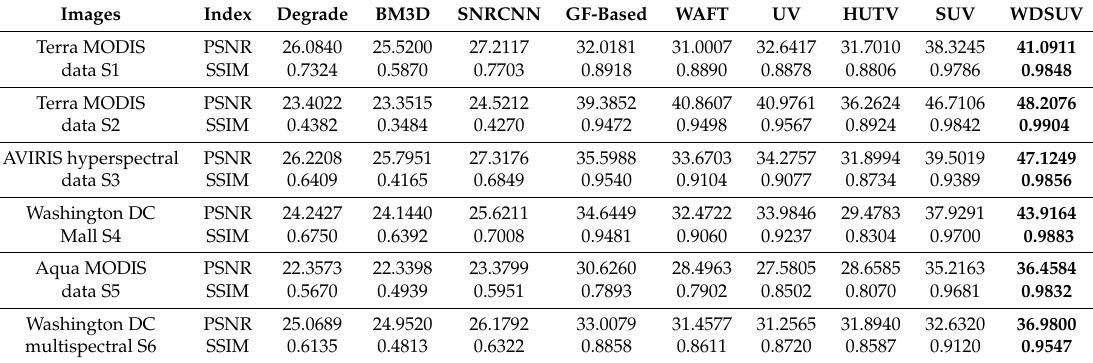
Table 1. Quantitative assessment of six simulated